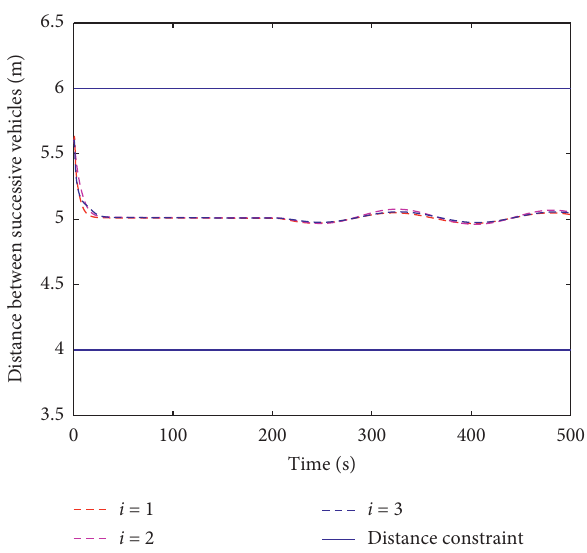
Figure 6: The distances between successive vehicles and constraints.